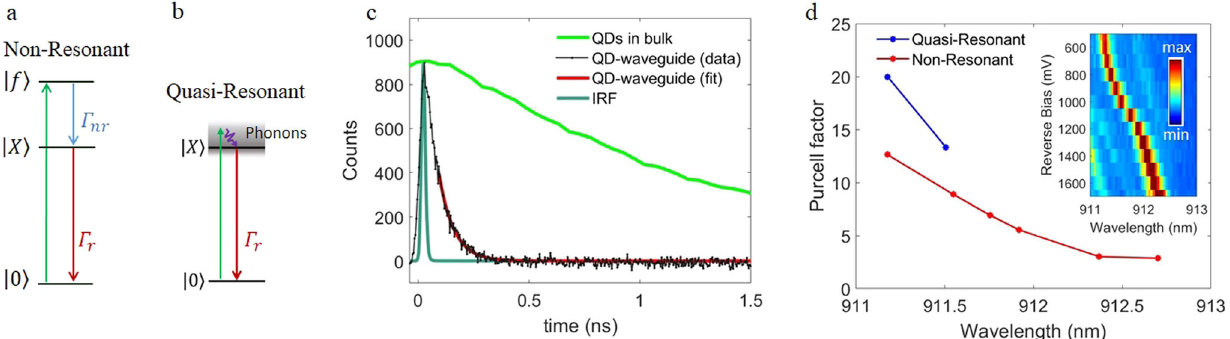
Fig. 2 Time-resolved PL measurements for the non-chiral QD. a Non-resonant excitation scheme. b Quasi-resonant phonon-sideband excitation scheme. The grey box shows the spectral density of the phonon states by using a gradient fi ll so that the grey fades out as we get further away from the transition in energy. c Lifetime measurement for a tuned QD at the slow-light region (dark dots, V = 0 V, B = − 4.5 T) under quasi-resonant phonon-sideband excitation. The solid red curve represents a single exponential fi t. For the quasi-resonant excitation, a small laser detuning of 2 meV was used to excite the phonon-side band of the QD line. That gave a very fast (few ps ) relaxation and thus revealed a radiative decay time of 60 ± 6 ps. The light green line shows photoluminescence decay of the QD ensemble in bulk measured with non-resonant excitation. The dark green line represents the instrument response function (IRF, FWHM = 20 ps ). d Wavelength dependency of the Purcell factor of the QD coupled to the slow-light PCW. The red and blue dots represent measured data under non-resonant above-band (808 nm) and phonon-sideband excitation schemes, respectively. The inset shows the PL scan for the coupled QD versus